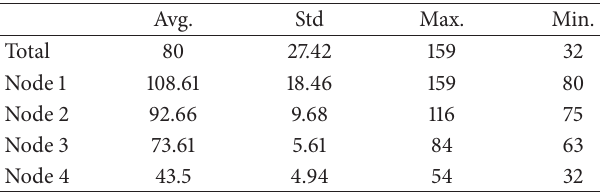
Table 1: Execution time statistics for 128 map tasks from job word-